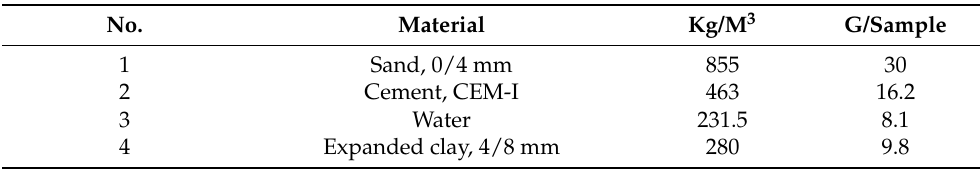
Figure 3. An illustrative representation of the sample preparation ( A ) and crack width measurement procedure ( B ). Table 2. Concrete mix